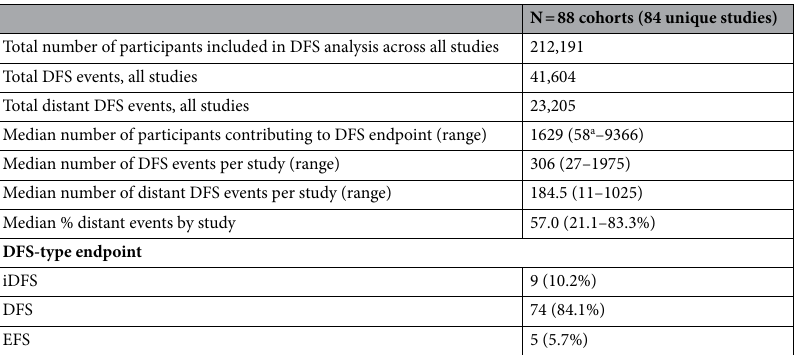
Table 1. DFS endpoint characteristics. a Although we excluded studies with less than 100 participants, this study was split into 2 cohorts for the analysis, but the total number of participants in the study was above 100. This table shows the DFS characteristics of the 88 cohorts included in this analysis. DFS disease free survival, iDFS invasive disease free survival, EFS event free